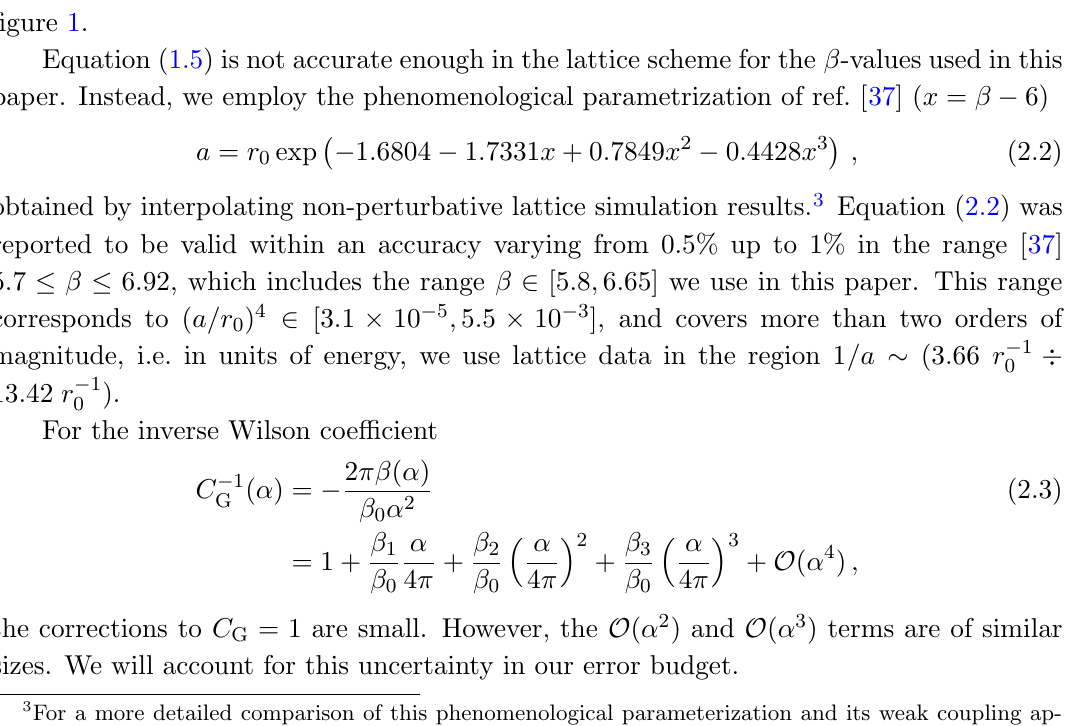
(cid:0) 1 Figure 1 . 36 C h P i MC (continuous blue line) and 36 C G (cid:25) 2 a 4 second line is basically indistinguishable with respect to zero with the scale resolution of this plot. The statistical errors are smaller than the size of the